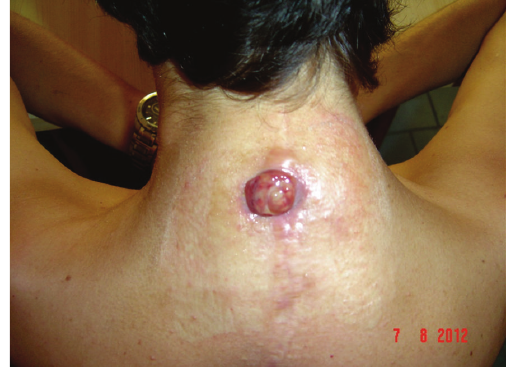
Figure 1: Formation of a round-shaped granuloma of about 2 centimetres along the surgical scar from a previous posterior spinal arthrodesis for kyphoscoliosis, in a patient with neurofibromatosis type 1. The granuloma evolved from a nodular lesion, which spon- taneously drained, with purulent discharge and formation of a fistulous tract.